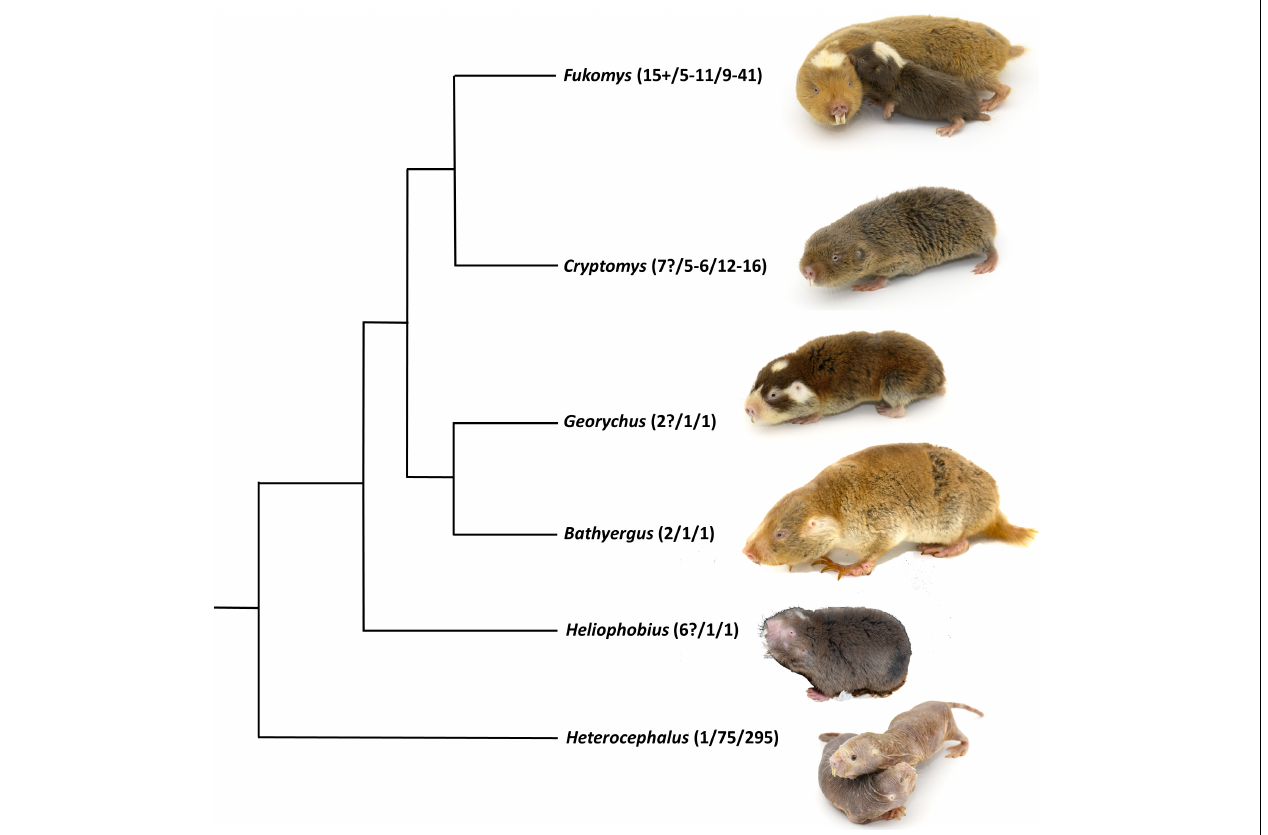
FIGURE 1 | Simplified phylogenetic tree for the family Bathyergidae indicating their main genera based on mitochondrial and nuclear genes. Numbers in brackets indicate the numbers of species for the genus, the average and maximum group size reported for various species in the genus. © Images Marietjie